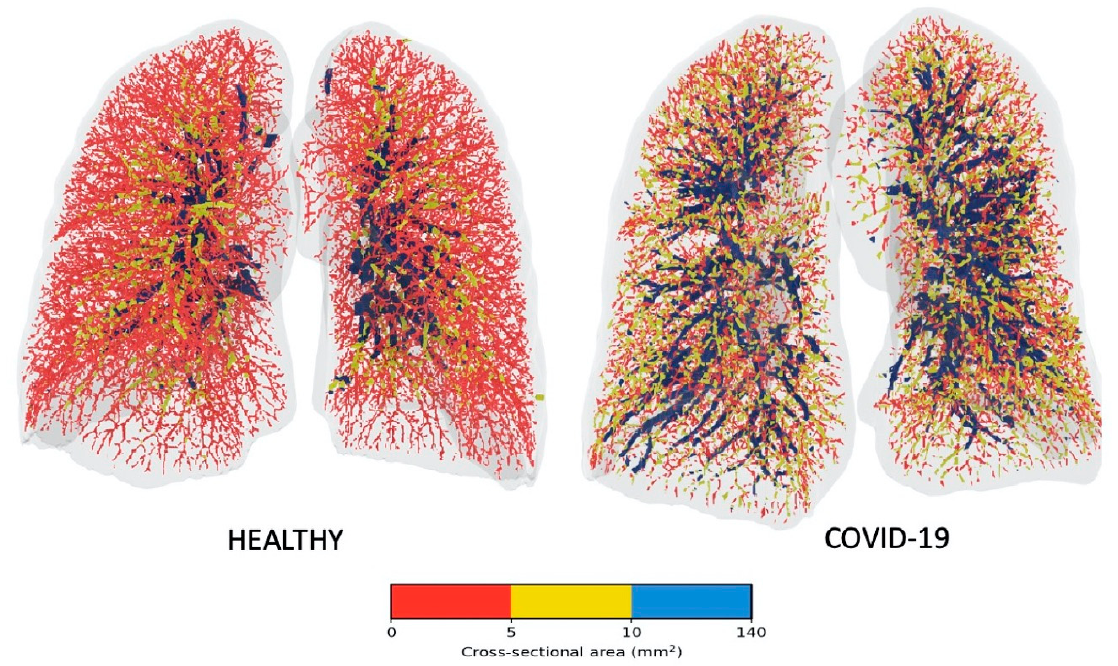
Figure 2. Visual representation of the blood vessels coloured according to their size. Red denotes the small vessels, yellow the mid-size vessels, and blue the larger vessels. Reprinted from ‘Academic Radiology’, Vol. 27, Issue 10, p. 1449–1455. Lins M, Vandevenne J, Thillai M, Lavon BR, Lanclus M, Bonte S, Godon R, Kendall I, De Backer J, De Backer W. Assessment of Small Pulmonary Blood Vessels in COVID-19 Patients Using HRCT. Figure 4, Page 1453. Copyright ( © 2020 The Association of University Radiologists), with permission from Elsevier.